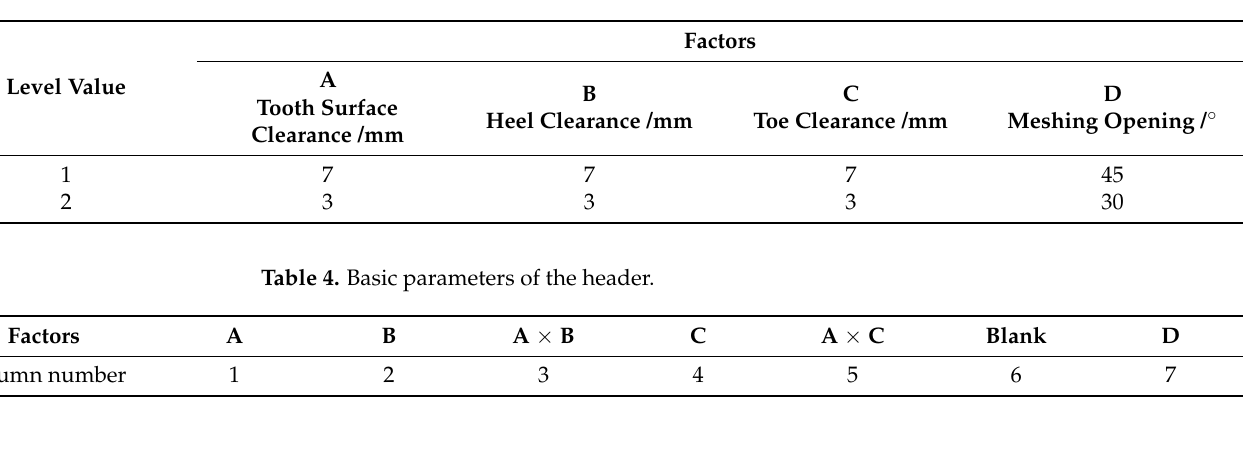
Table 3. Factor levels.